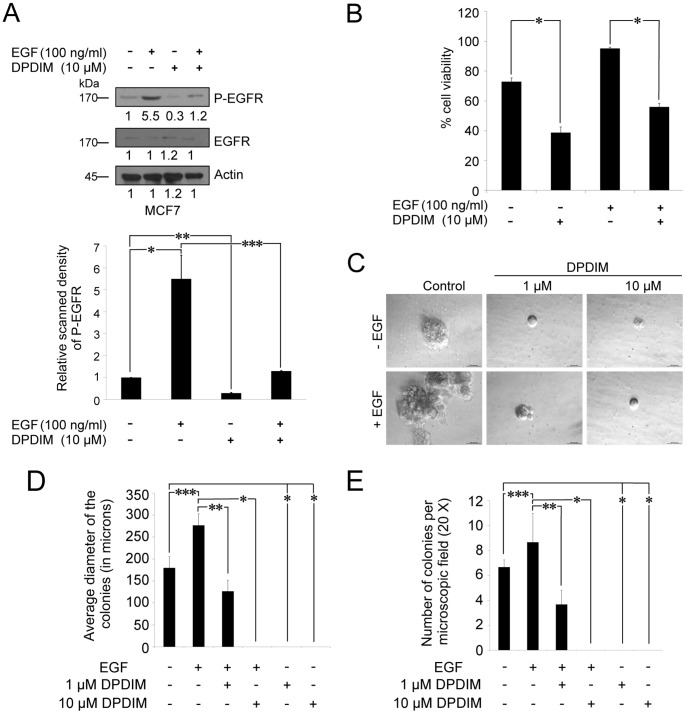
Inhibition of EGF induced EGFR activation, cell viability and colony formation of MCF7 cells by DPDIM.(A and B), Effect of DPDIM on EGFR phosphorylation and cell viability in EGF induced cells. MCF7 cells were treated with 100 ng/ml of EGF for 6 hr followed by 10 µM DPDIM for additional 24 hr. (A), Phosphorylation of EGFR in DPDIM treated and untreated cells in the presence or absence of EGF were detected by IB. Results are representative of three independent experiments. Densitometric value of each IB band is mentioned in the figure. Bar graph with SD represents the relative scanned density of phospho EGFR bands of MCF7 cells treated with or without EGF and DPDIM. (*P = 0.002, **P < 0.0001, ***P = 0.0025) (B), Cell viability of these DPDIM treated and untreated cells in the presence or absence of EGF were measured by MTT assay. The bars represent the percent (%) cell viability and standard deviation (SD) obtained from three independent experiments. *indicates P<0.0001 (C), 100 ng/ml of EGF induced or uninduced MCF7 cells treated with either 1 µM or 10 µM DPDIM were plated at a density of 5000 cells per 35 mm dish. EGF/DPDIM or both were fed every alternative day with media exchange. After incubation of 14 days plates were examined under a microscope and representative photographs of the colonies were taken. (D), The average diameters of the colonies were computed and represented by bar graph (n = 3, ***P = 0.0101, **P = 0.0019, *P = 0.003) with SD. (E), Colonies with the diameter of ∼100 µm were counted from three individual 20X microscopic fields. Average number of colonies for each treated and untreated plates were plotted as bar graphs with their representative SD (***P = 0.0078, **P = 0.0048, *P < 0.0001).